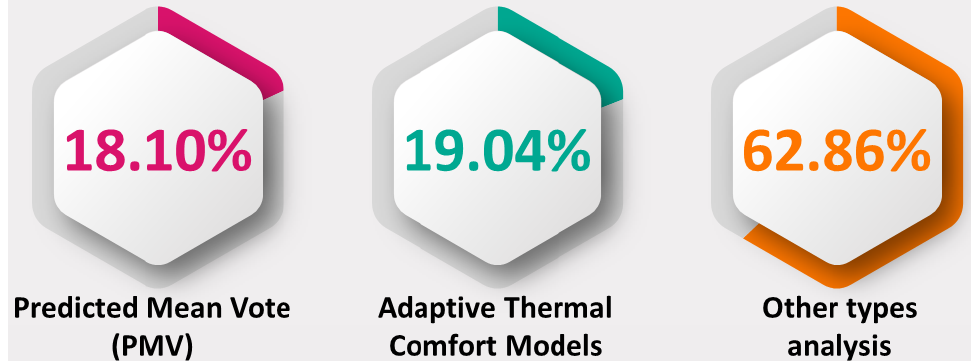
Figure 7. Methods used to evaluate thermal comfort.